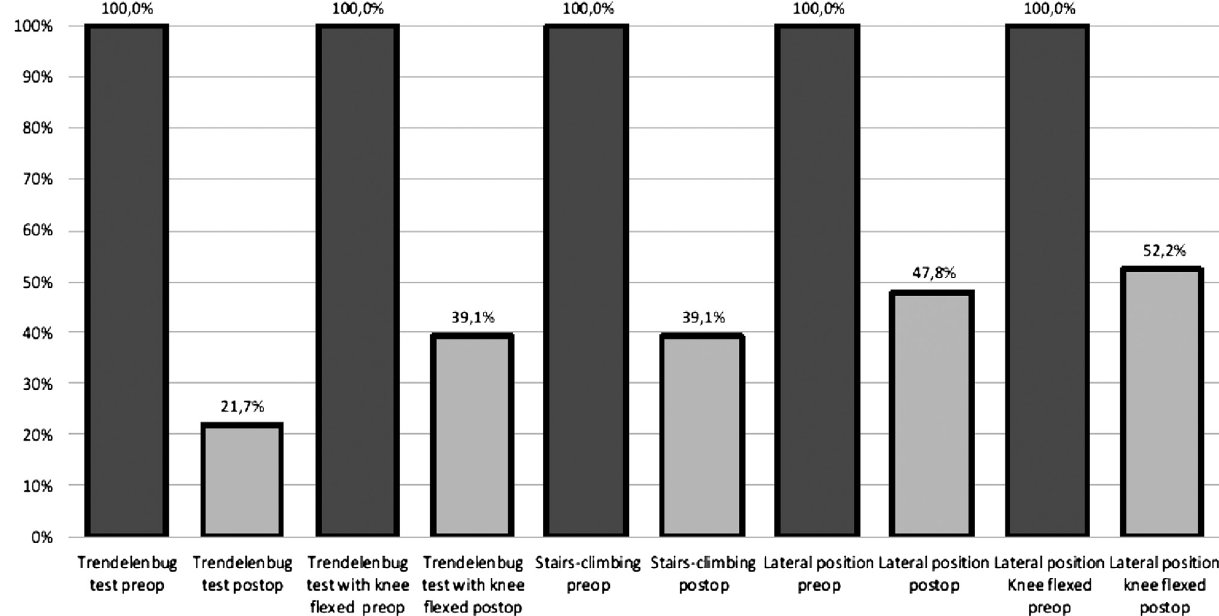
Figure 5. Trendelenburg test and variants scores before (preop) and after (postop) surgery.